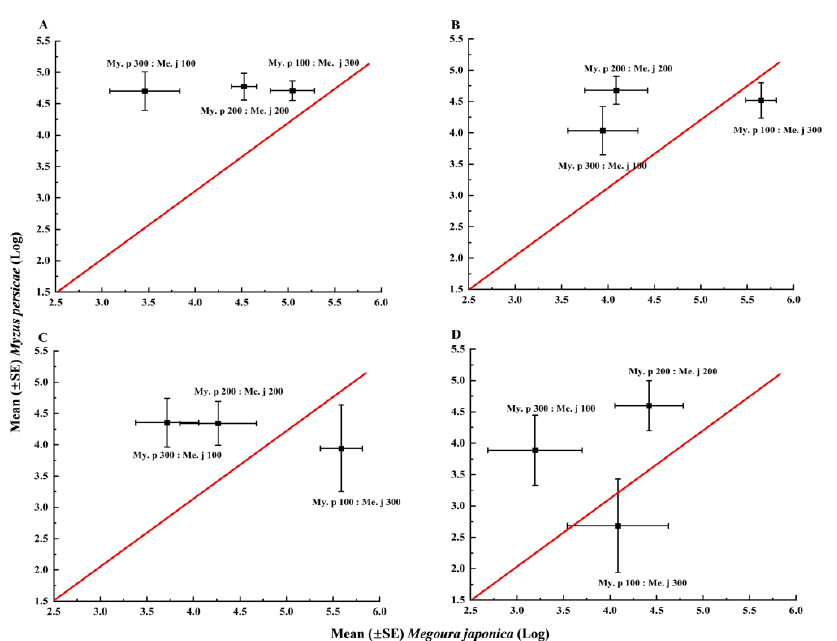
Figure 3. The relationship between Myzus persicae and Megoura japonica under different initial ratios on the 1st ( A ), 3rd ( B ), 6th ( C ), and 9th day ( D ). My. p represents My. persicae , and Me. j represents Me. japonica.